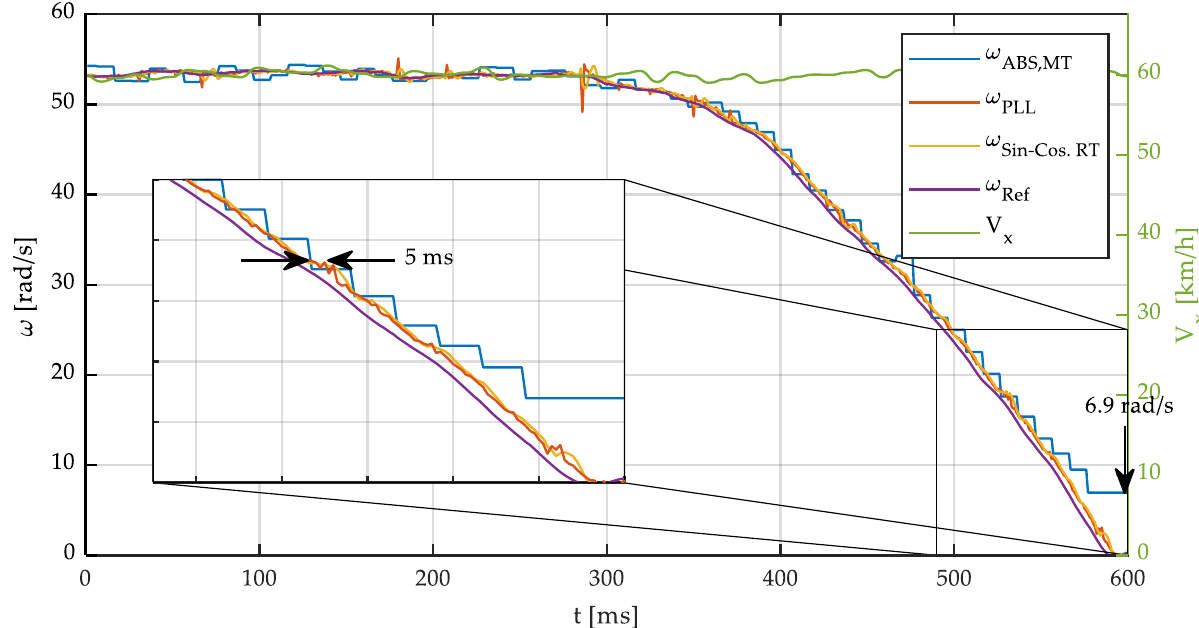
Figure 15. Wheel angular speed and linear speed vs. time. Vehicle speed 60 km/h.